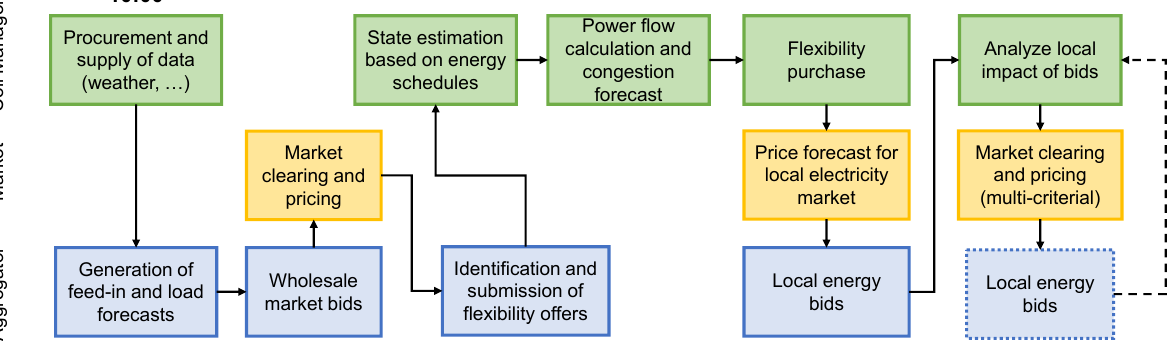
Figure 4. Operational concept for the day-ahead process.